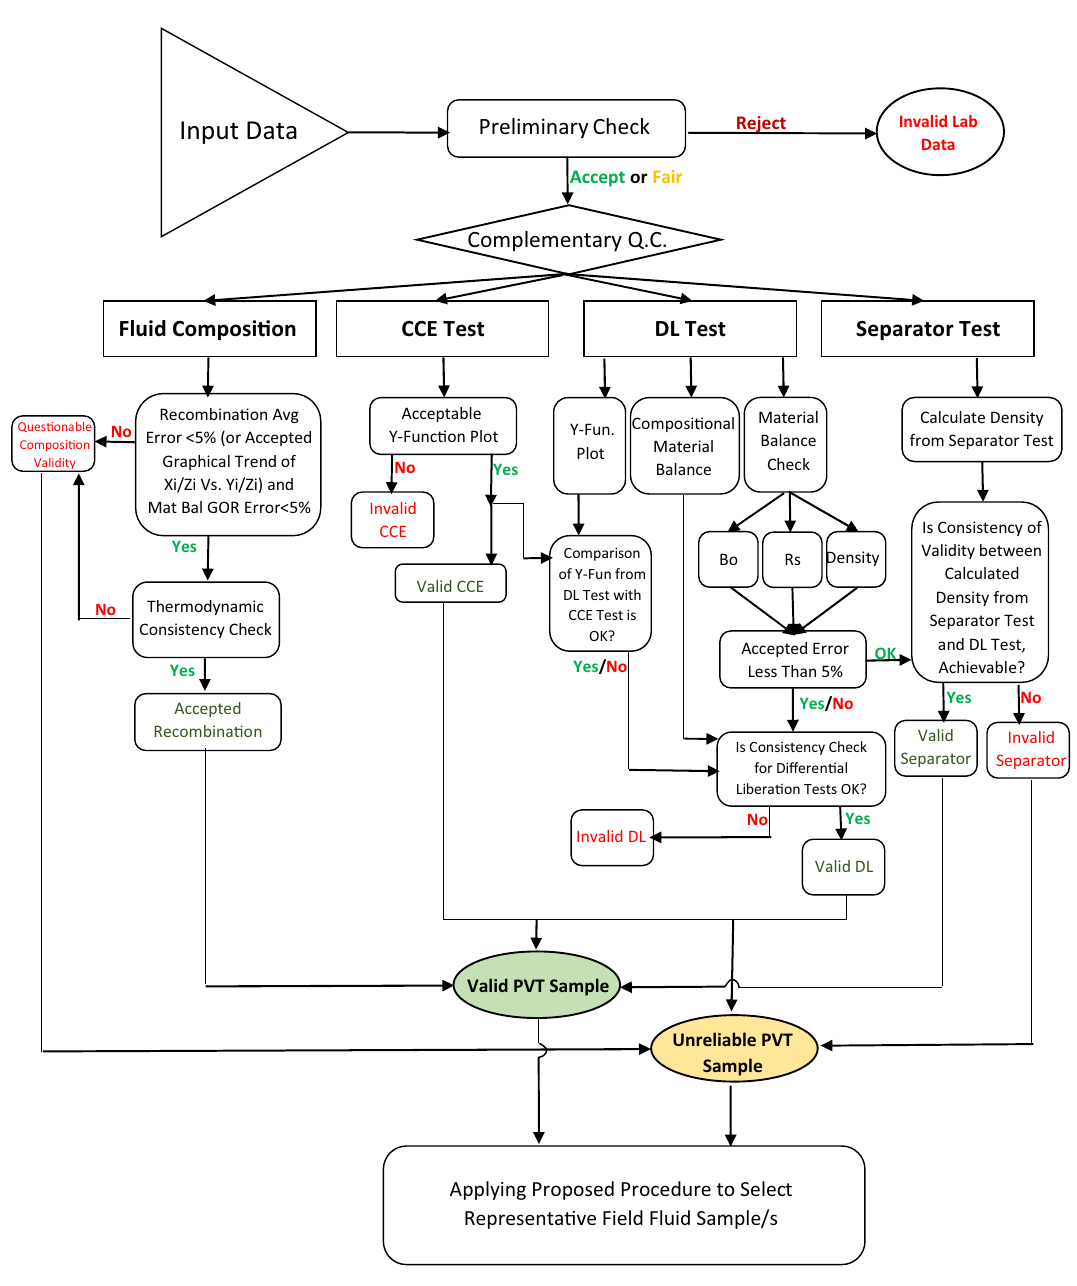
Fig. 5 Reservoir representative fluid samples selection